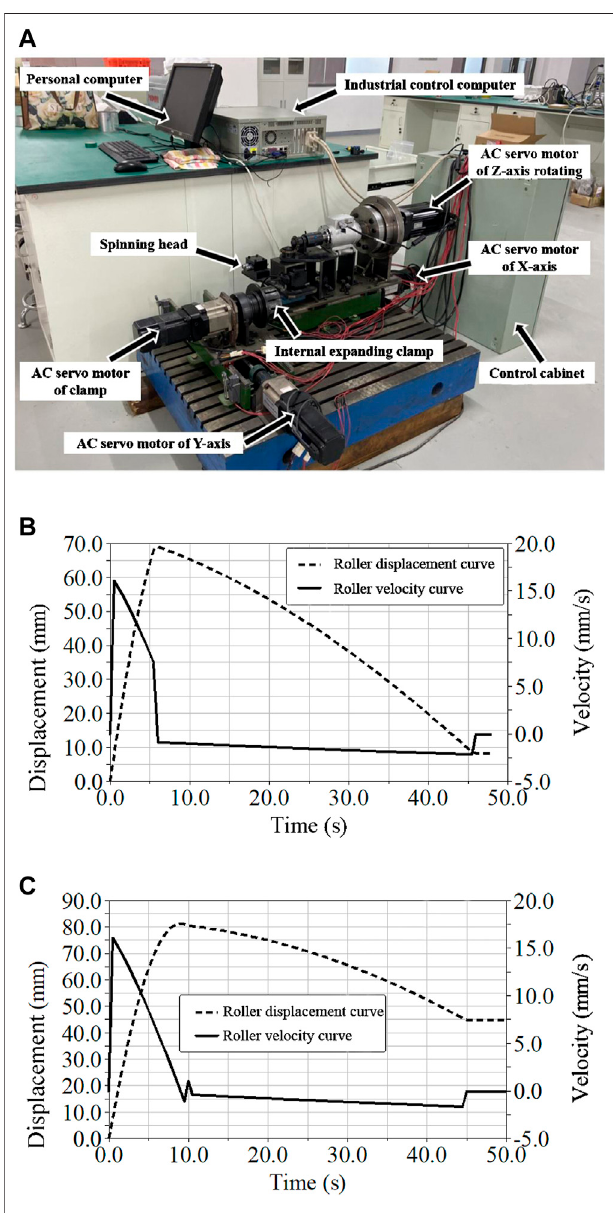
FIGURE 9 | Experimental set-up and motion curves of the rollers. (A) Experimental set-up. (B) When forming the contraction section. (C) Motion curves of the rollers when forming the expanding